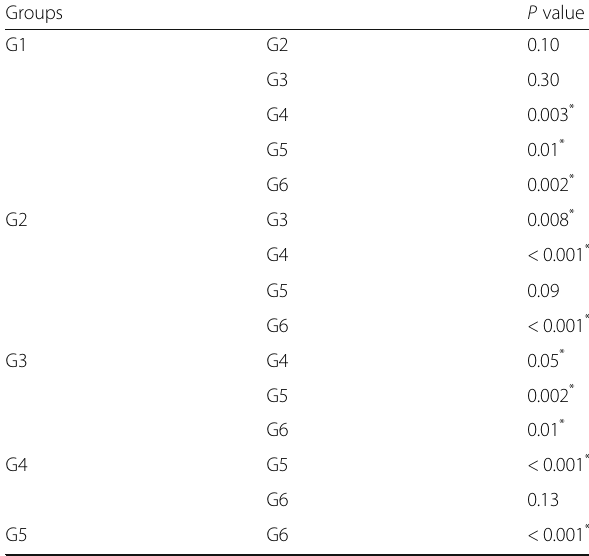
Table 2 Pairwise comparison of microbial contamination between the groups Groups